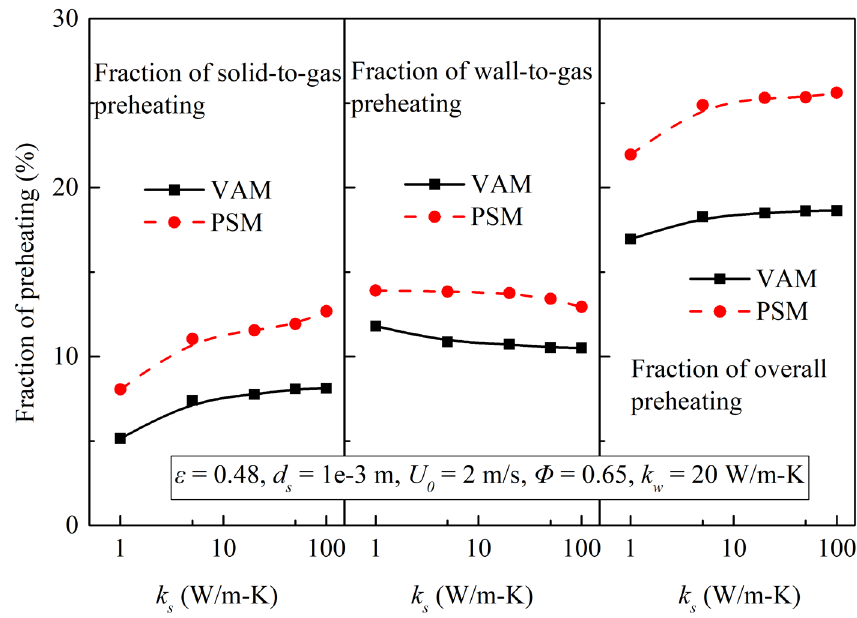
Figure 13. Effects of k s on the fraction of preheating obtained by the PSM and VAM.